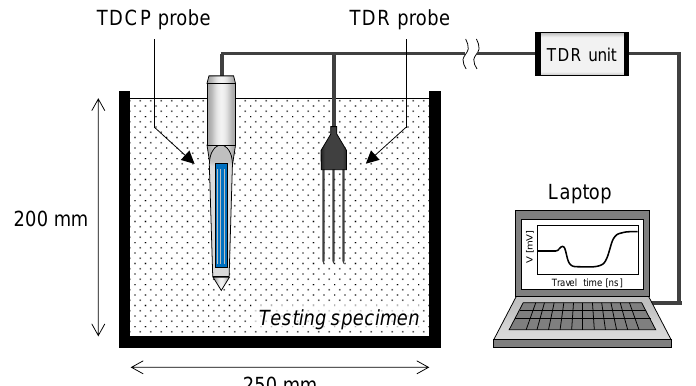
Figure 4. Calibrations using the TDR and TDCP probes.